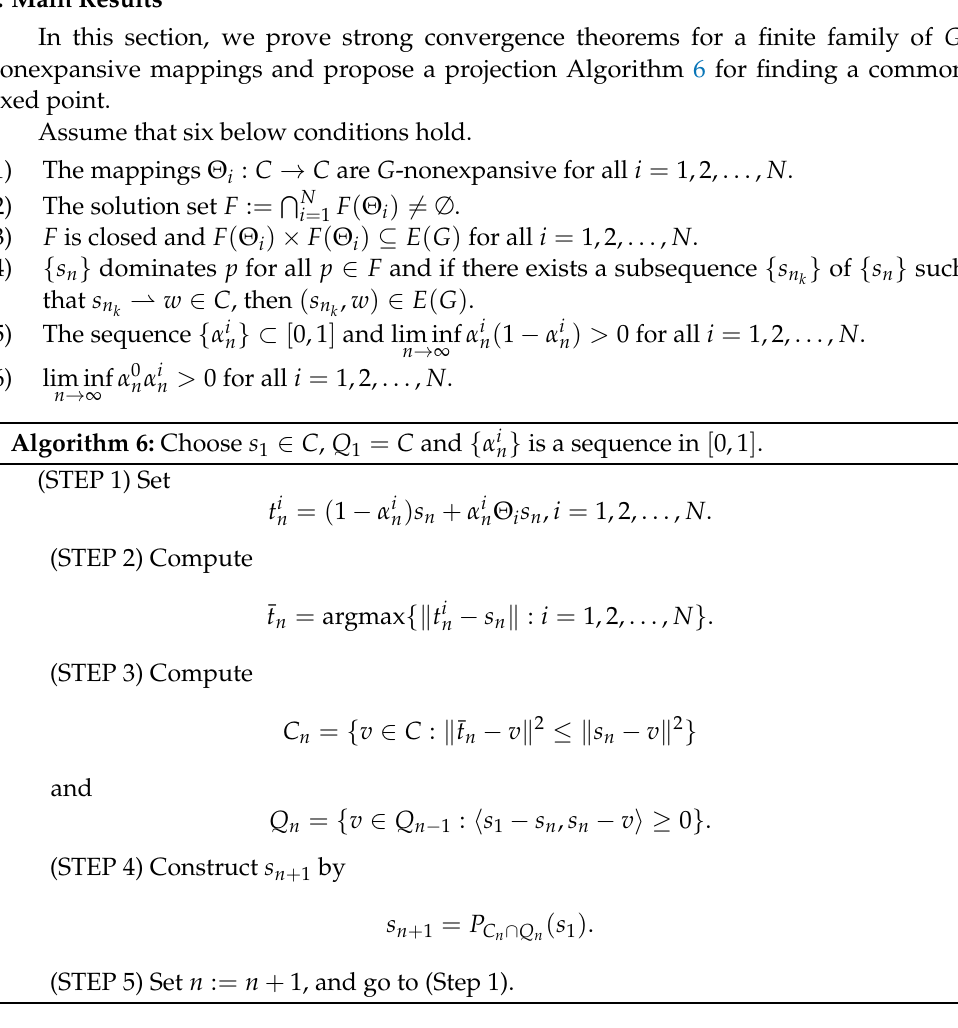
Algorithm 6: Choose s 1 ∈ C , Q 1 = C and { α i